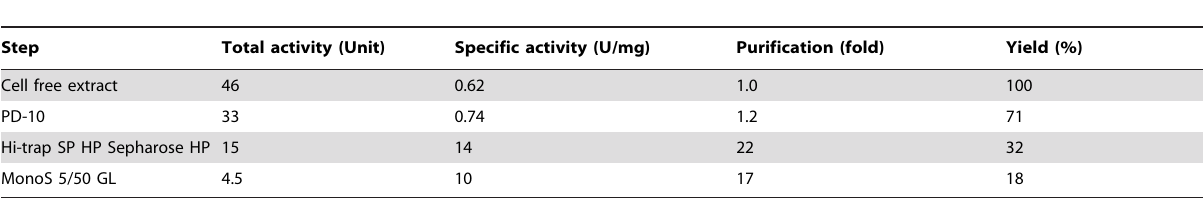
Table 1. Purification scheme of the La 3 + -dependent MDH isolated from M. extorquens strain AM1.